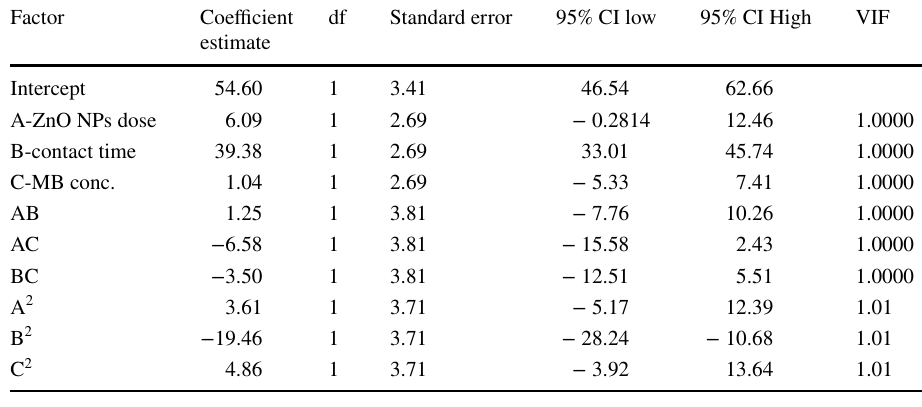
Fig. 10 The desirability ramp for the optimization of three factors (viz. ZnO NPs dose, contact time and MB conc.) to yield maximum dye removal (%) using the as-synthesized ZnO NPs adsorbent